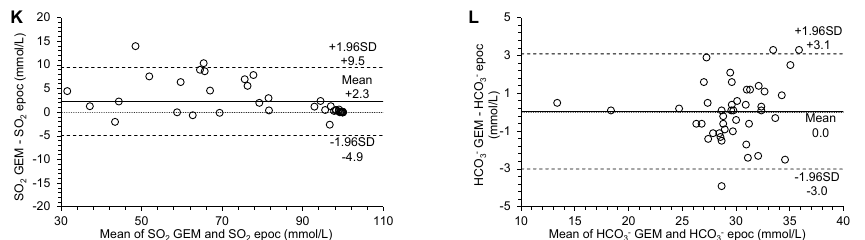
Figure 1. Bland-Altman plots for comparison of GEM5000 and epoc analyzers for blood pH ( A ), pCO 2 ( B ), pO 2 ( C ), Na + ( D ), Cl − ( E ), Ca 2+ ( F ), K + ( G ), packed cell volume PCV ( H ), tHb ( I ), BE ( J ), SO 2 ( K ), [HCO 3 − ] ( L ). The dashed lines are upper and lower limit of agreement, the solid line is the mean difference Table 4. Results of the Passing–Bablok regression and the Bland–Altman plots resulting from the comparison between the GEM5000 and the epoc analyzer.